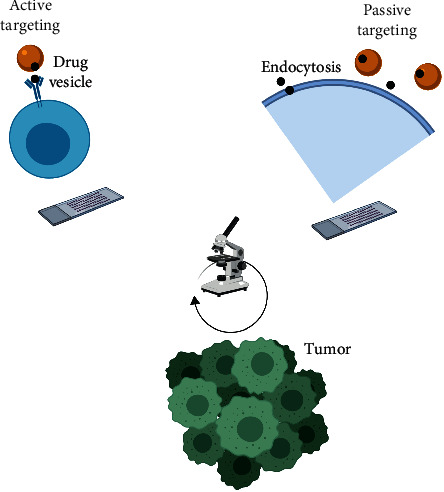
Active versus passive tumor targeting. In active targeting, the drug needs a receptor at the tumor surface, whereas in passive targeting, the drug enters the target cells passively.